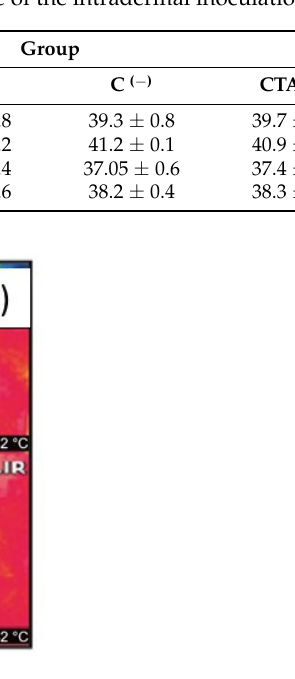
Figure 6. ( a ) Induration reactions at the site of inoculation observed at 72 h post inoculation; ( b ) thermography image.